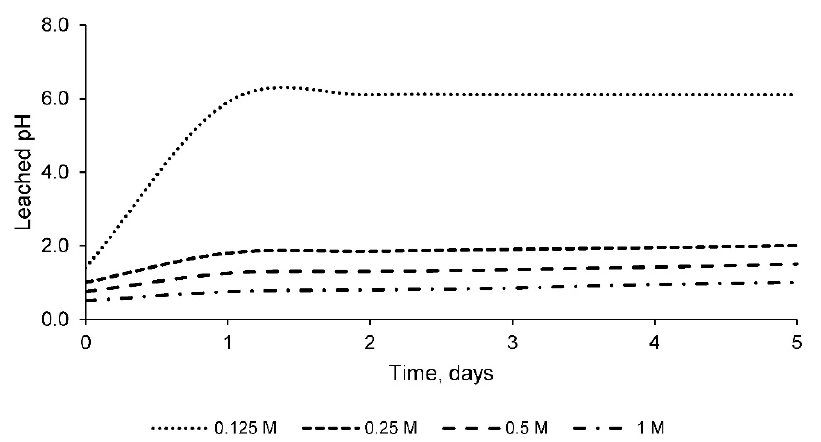
Figure 1. pH of 0.125, 0.25, 1, and 2 molar solutions of sulfuric acid at different times during leaching process with electric furnace dusts. process with electric furnace